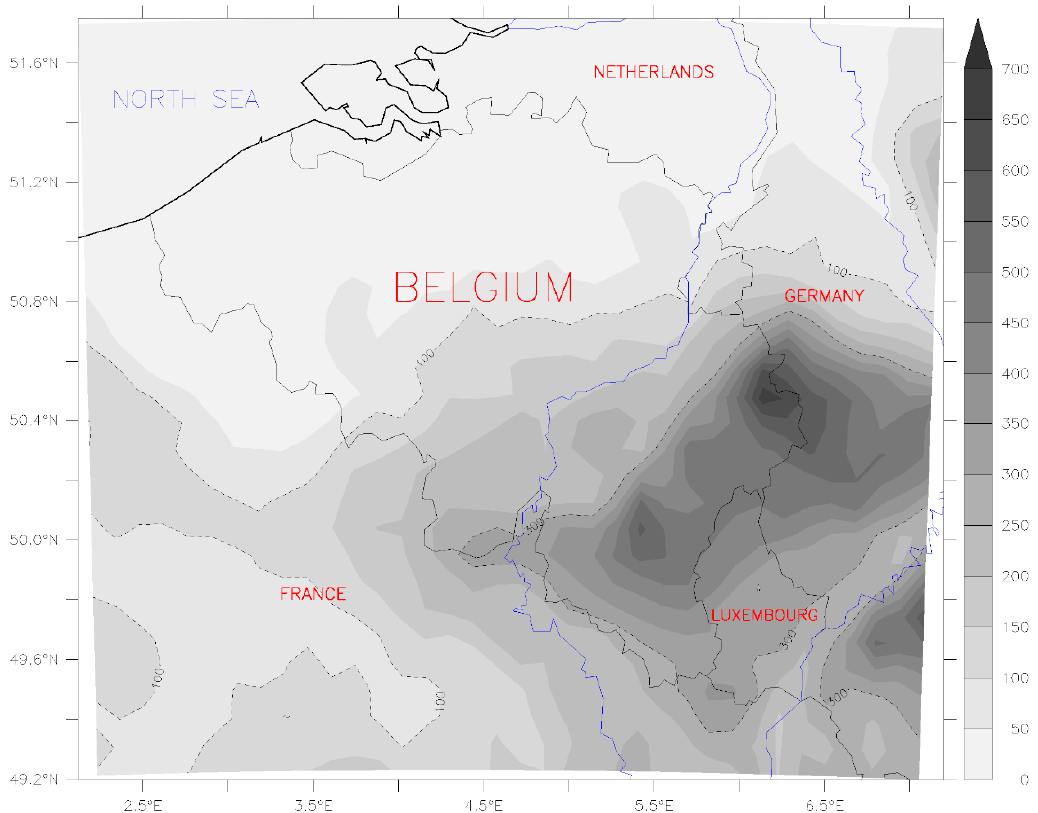
Figure 1. Model elevation of the study area (in meters). The dotted black lines represent the 100-m and 300-m elevation; the blue lines represent the main rivers in our studied area, and the country (in red letters) borders are shown by solid black lines.